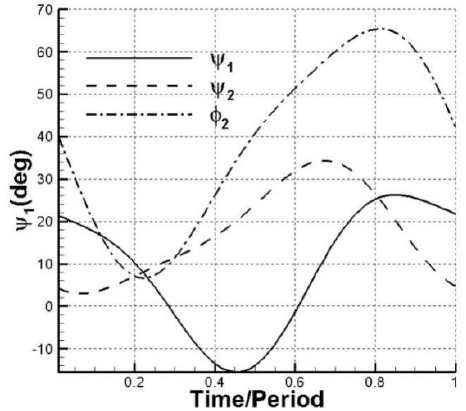
Figure 4. The variation of flapping angle and sweep angle.